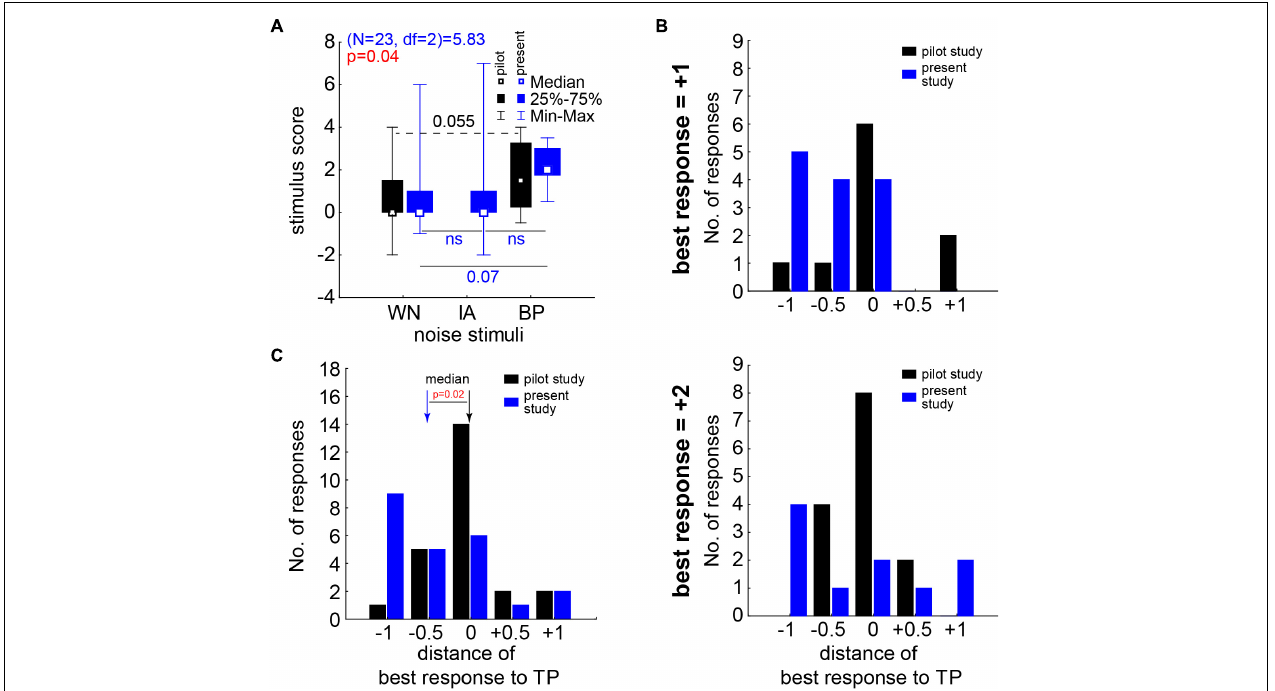
FIGURE 6 | Stimulus score and best responses in comparison to our first pilot study’s data (Schilling et al., 2020). (A) Median stimulus score of the pilot study (black symbols and numbers) and this study (blue/red symbols and letters/numbers). Pilot study statistics with Wilcoxon test (broken line); this study with Friedman ANOVA and Wilcoxon tests (solid lines) corrected for repeated comparisons. (B) Number of best responses in both studies dependent on the distance to TP of the center frequency of the BP noises. Upper panel: results for best response of +1. Lower panel: results for best response of +2. (C) Complete distributions of best responses in both studies; median of both studies significantly different (Mann–Whitney U